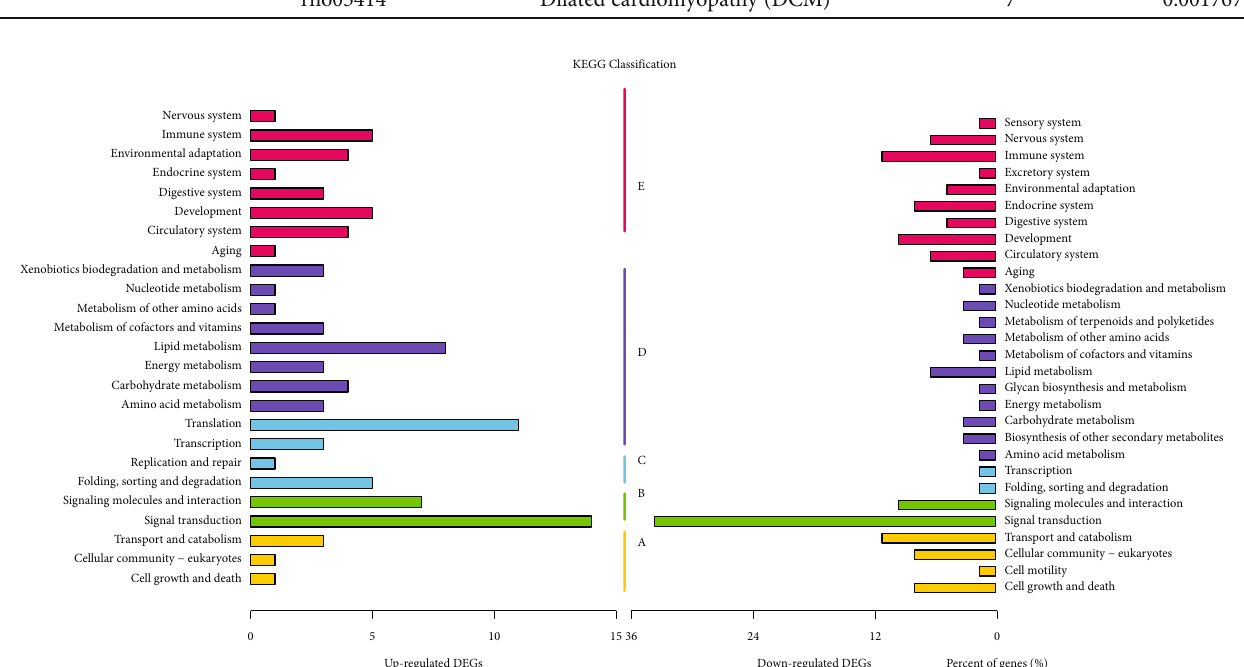
Figure 4: KEGG classi fi cation analysis of upregulated and downregulated DEGs. (a) Cellular processes. (b) Environmental information processing. (c) Genetic information processing. (d) Metabolism. (e) Organismal